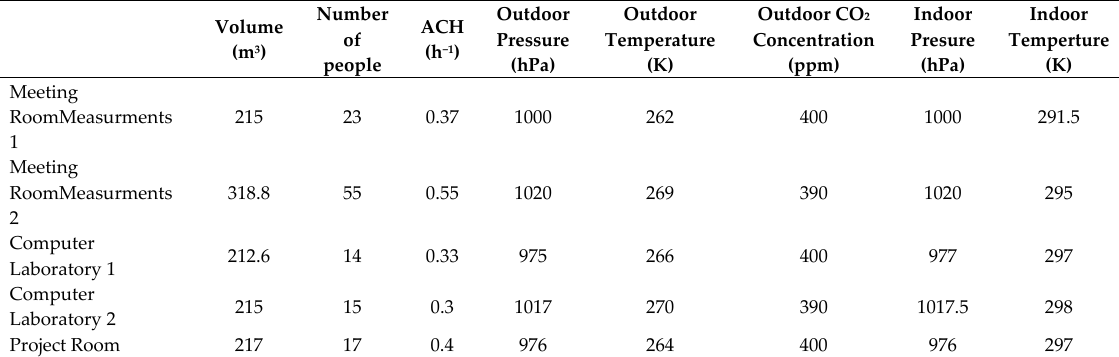
Table 1. Parameters of rooms and atmospheric conditions during